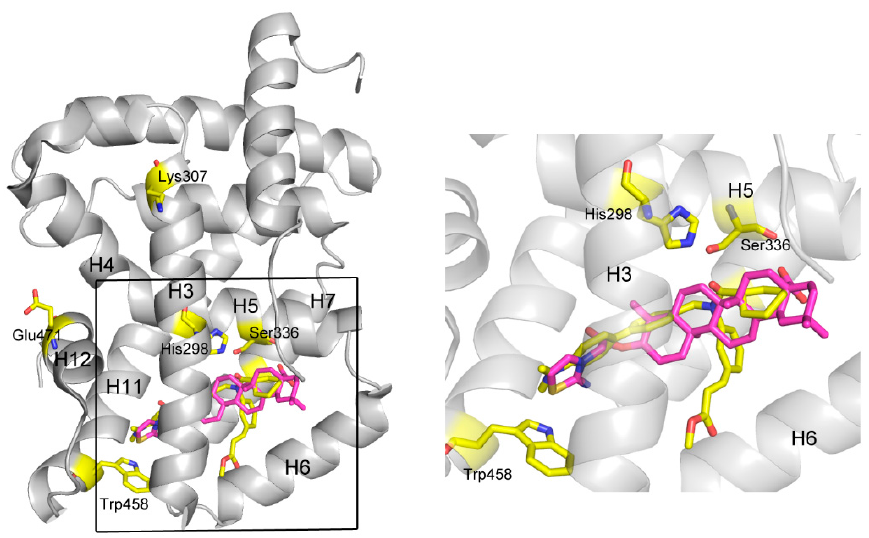
Figure 4. Binding modes of fexaramine (yellow) and compound 3b (magenta) into FXR. Key residues involved in the formation of “charge clamp” and the interactions with fexaramine and compound 3b are all marked and presented as sticks. Helices discussed in the text are numbered.